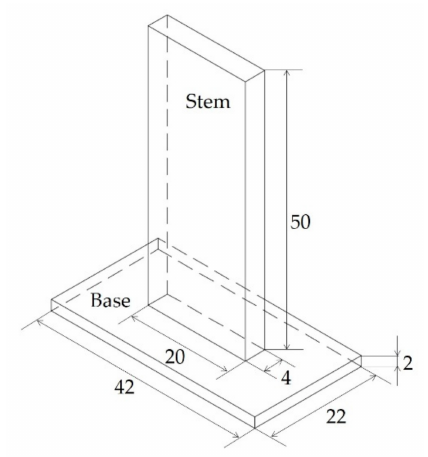
Figure 2. Design of the T-joint specimen. All dimensions are in millimeters.